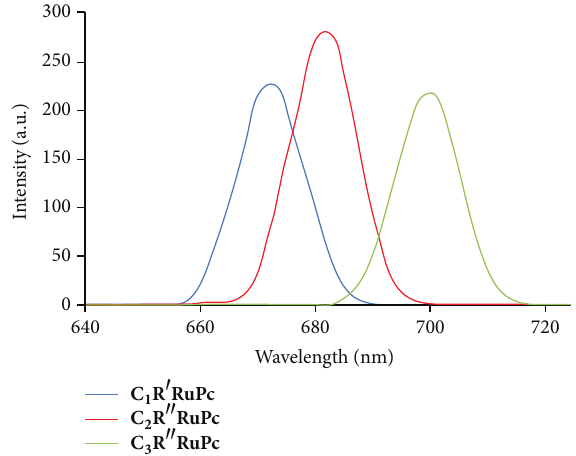
Figure 2: Emission spectra of ( C 1 R 󸀠 RuPc ), ( C 2 R 󸀠󸀠 RuPc ), and ( C 3 R 󸀠󸀠 RuPc ) in DMF solution.